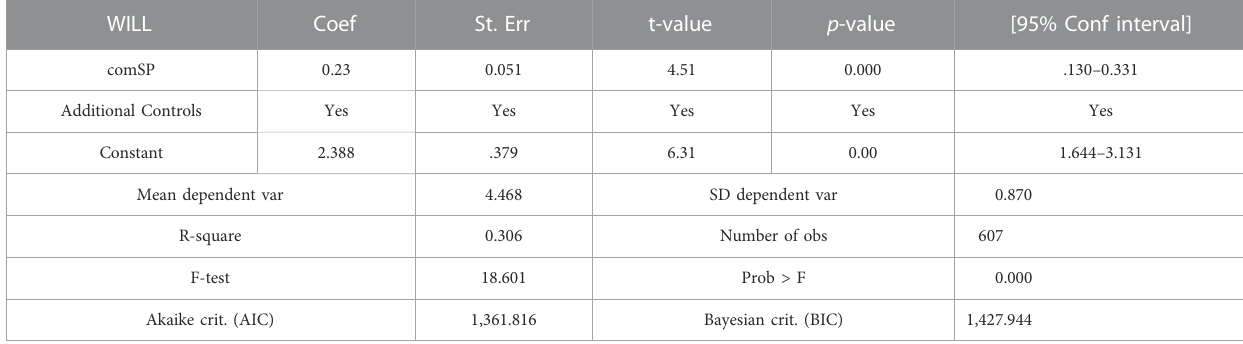
TABLE 8 Regression results of policy comprehensive score and farmers ’ resource utilization willingness (Model 14).